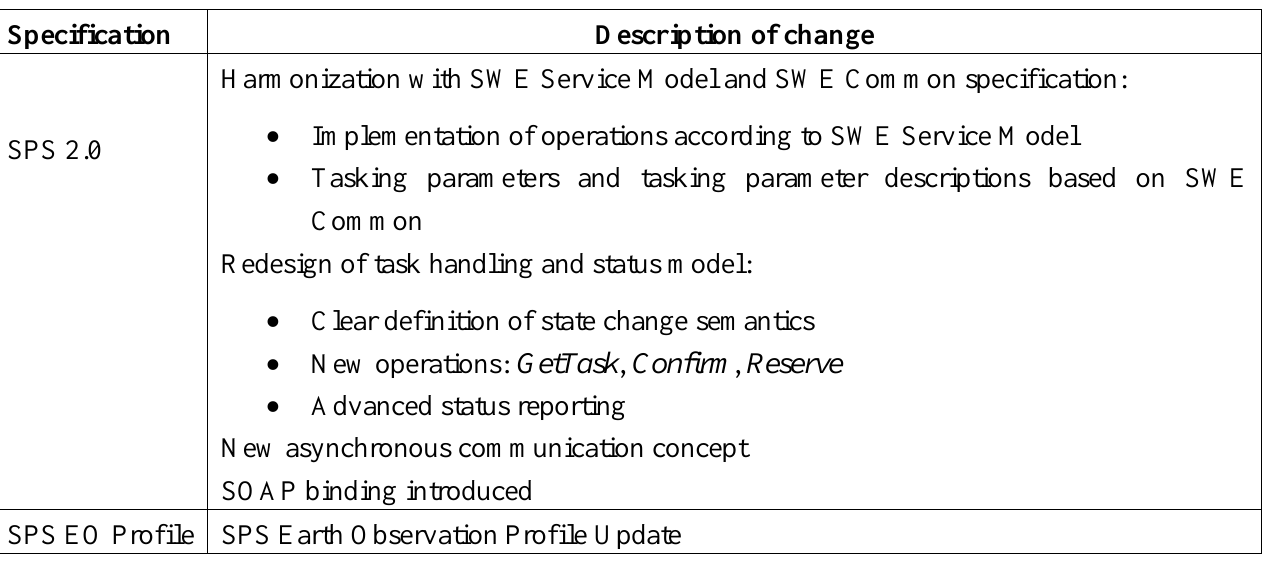
Table 4. Major changes of SPS